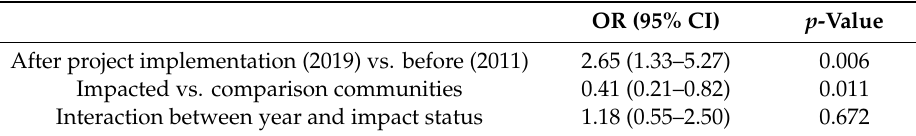
Table 2. Logistic regression model comparing the prevalence of P . falciparum in children aged 6–59 months before (2011) and 8 years after implementation of the project (2019) in impacted and non-impacted comparison communities, Trident project, Zambia. OR (95% CI) p -Value After project implementation (2019) vs. before (2011)